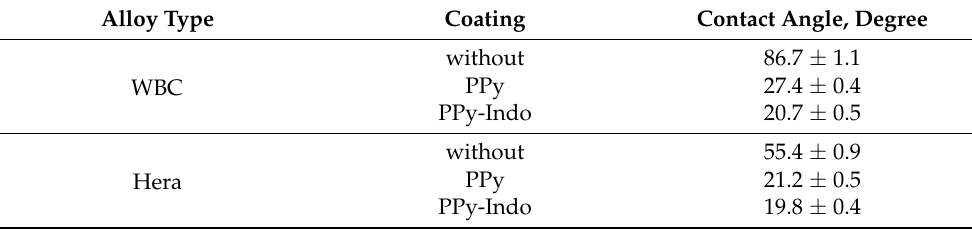
Table 2. Contact angles of CoCr based alloys, with and without PPy or PPy-Indo